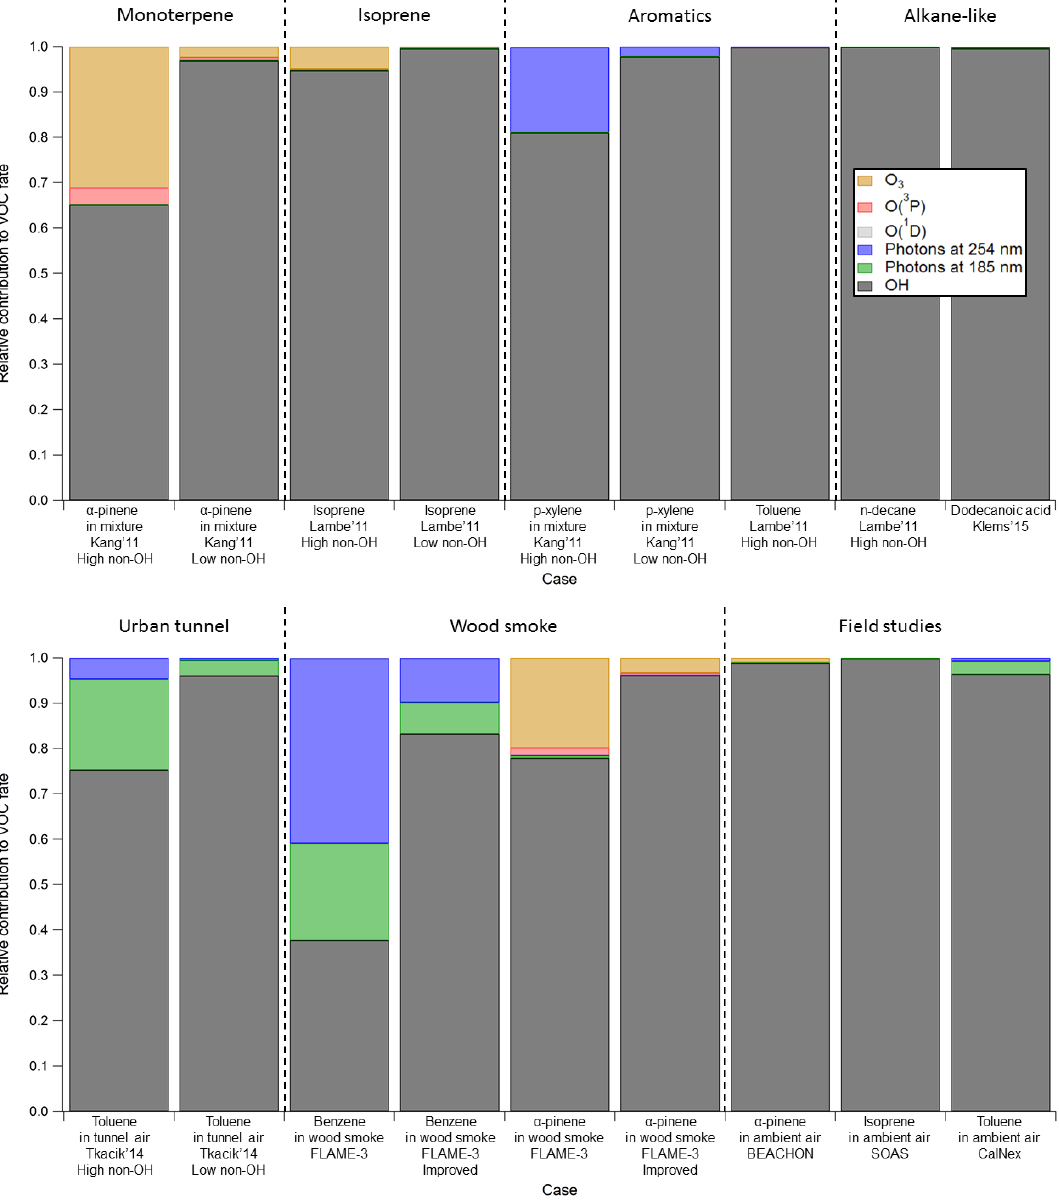
Figure 7. VOC fate in several representative cases of the laboratory, source, and field studies examined in this work. More details on VOC fate in these studies can be found in Table